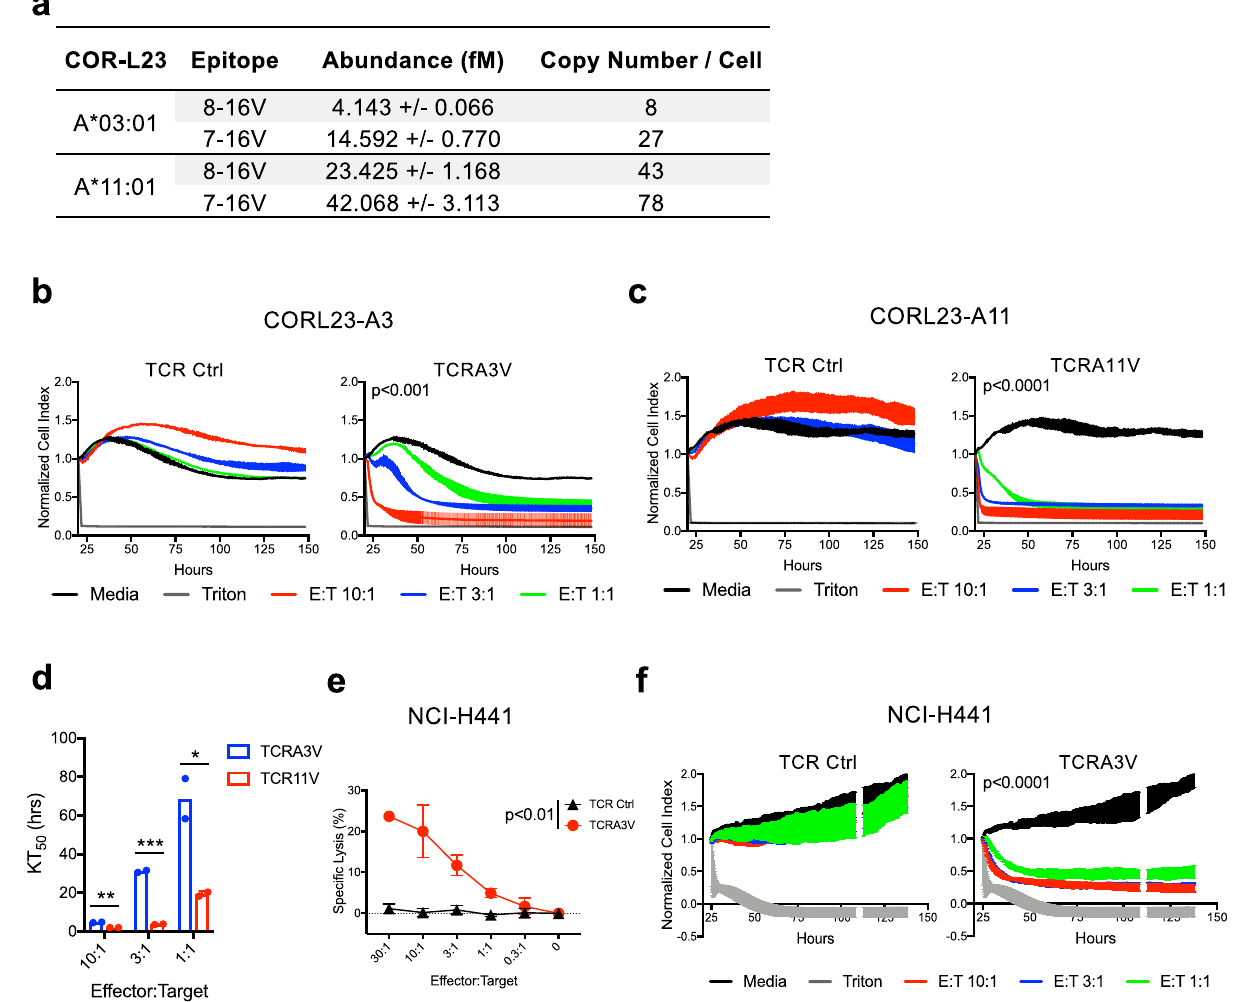
Fig. 5 Quantitation and recognition of KRAS G12V peptide ligands presented by human tumor cell lines. a Absolute quanti fi cation of cell surface expression of 8-16V/HLA and 7-16V/HLA complexes by CORL23-A3 and CORL23-A11 cells. Data are representative of two independent experiments. b Cellular impedance to determine the kinetics of tumor cell death upon TCRA3V lytic recognition of CORL23-A3 vs TCR Ctrl (TCRA11V). Normalized cell index values over time for E:T ratios of 10:1, 3:1, and 1:1 are shown compared to tumor cells cultured in media alone. Data for cells exposed to triton-X to represent maximal impedance loss are displayed. Data are presented as mean values ± SD. p < 0.001 at 150 h for all E:T ratios for the TCRA3V group compared to media; one-way ANOVA followed by post-hoc pair-wise Student ’ s t -test with multiple comparison adjustment. Data are representative of two independent experiments. c Cellular impedance data following TCRA11V lytic recognition of CORL23-A11 vs TCR Ctrl (TCRA3V). Data are presented as mean values ± SD. p < 0.0001 at 150 h for all E:T ratios for the TCRA11V group compared to media; one-way ANOVA followed by post-hoc pair-wise Student ’ s t -test with multiple comparison adjustment. Data are representative of two independent experiments. d Comparative kinetics of the time to reach 50% cell death (KT50) of CORL23-A3 and CORL23-A11 cells upon TCRA3V and TCRA11V recognition, respectively, at E:T ratios of 10:1, 3:1, and 1:1. Data are presented as mean values with independent replicates displayed. * p < 0.05, ** p < 0.01, *** p < 0.001; multiple t -test analysis. Data are representative of two independent experiments. e 4 h 51 Cr-release cytotoxicity assay demonstrating TCRA3V tumoricidal activity against NCI-H441 cells (G12V + /HLA- A*03:01 + ) compared to TCR Ctrl (TCRA11V) cells. Data are presented as mean values ± SD. p < 0.01 for all E:T ratio ≥ 1:1; one-tailed Student ’ s t -test. Data are representative of two independent experiments. f Cellular impedance data following TCRA3V lytic recognition of NCI-H441 vs TCR Ctrl (TCRA11V). Data are presented as mean values± SD. p < 0.0001 at 130 h for all E:T ratios for the TCRA3V group compared to media; one-way ANOVA followed by post-hoc pair-wise Student ’ s t -test with multiple comparison adjustment. Data are representative of two independent experiments. Source data are provided as a Source Data fi